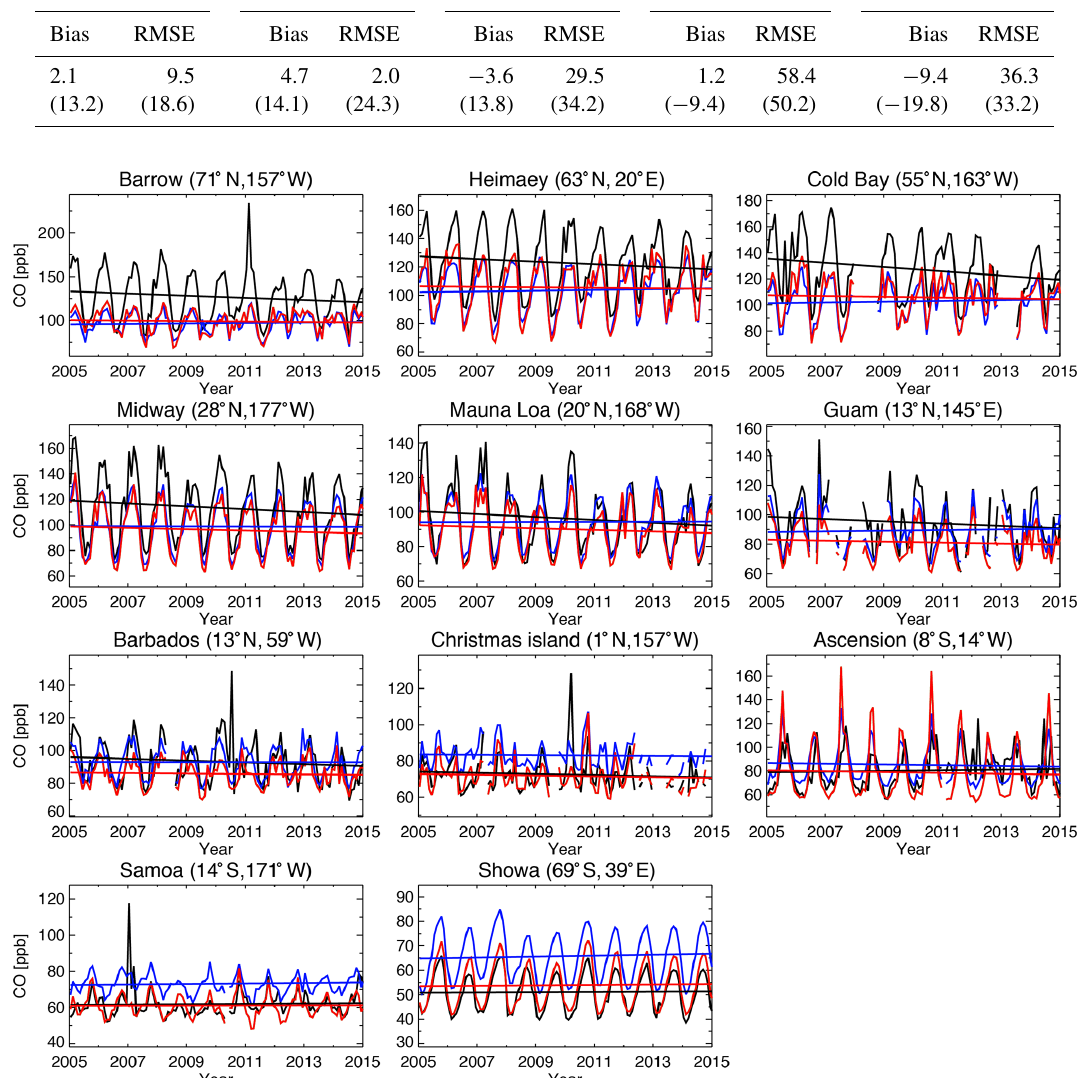
Figure 7. Time series of monthly mean surface CO concentrations obtained from the WDCGG ground measurements (black), the control run (blue), and reanalysis